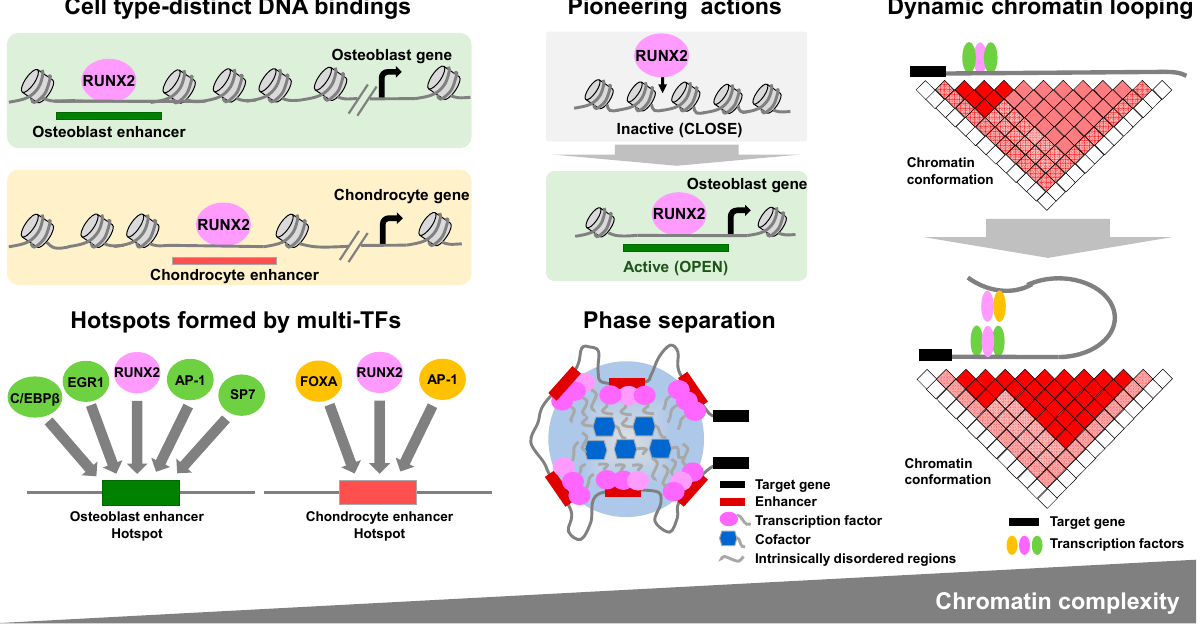
Figure 1. Overview of models of RUNX2 ‐ mediated multi ‐ layered gene regulatory mechanisms in skeletal cells.